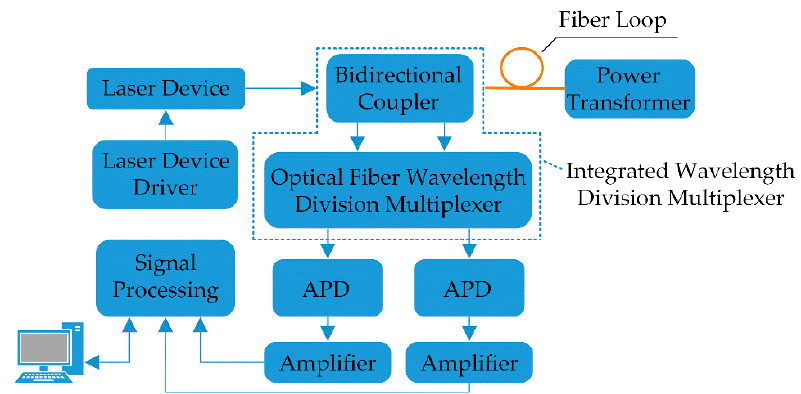
Figure 2. Power transformer temperature monitoring principle based on distributed optical fiber sensing.